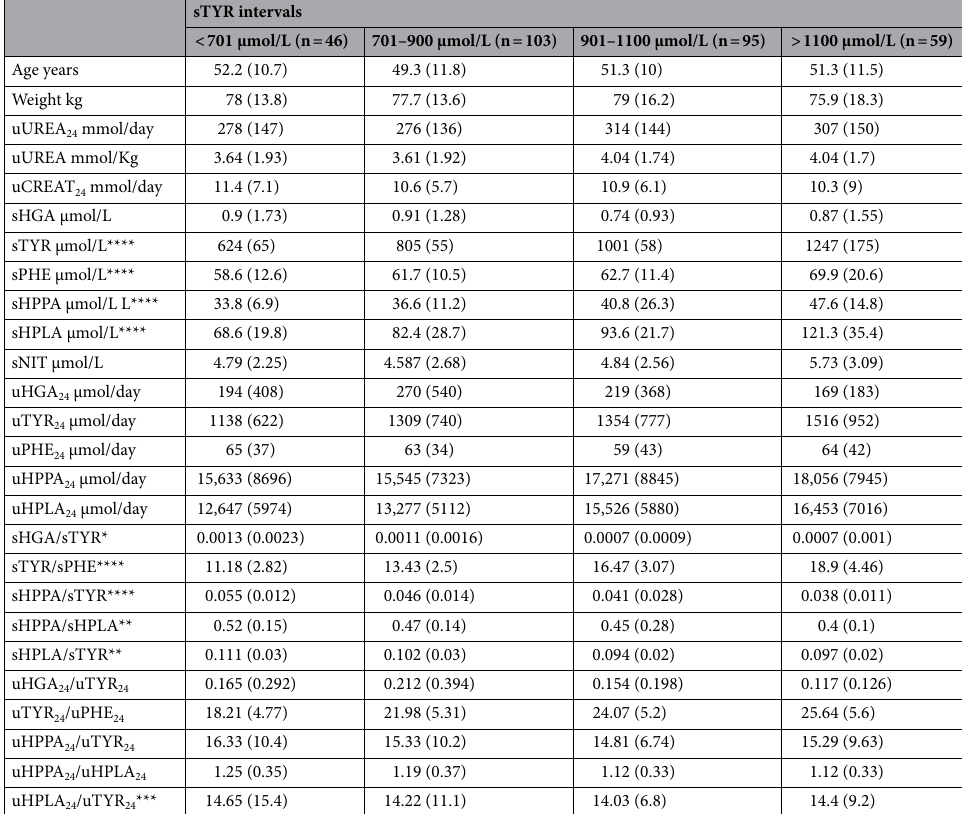
Table 1. Measured metabolic data stratified according to sTYR groups in NIT-treated AKU patients. Demographic and measured data are shown according to sTYR intervals of < 701, 701–900, 901–1100 and > 1100 µmol/L. Variation among column means is significantly greater than expected by chance with p < : * < 0.05; ** < 0.01; *** < 0.001; **** < 0.0001; within sTYR group comparisons are shown in figures (main and supplementary). S, serum; uX 24 , 24-h urine; HGA, homogentisic acid; TYR, tyrosine; PHE, phenylalanine; HPPA, 4-hydroxyphenylpyruvate; HPLA, 4-hydroxyphenyllactate; NIT, nitisinone; CREAT,